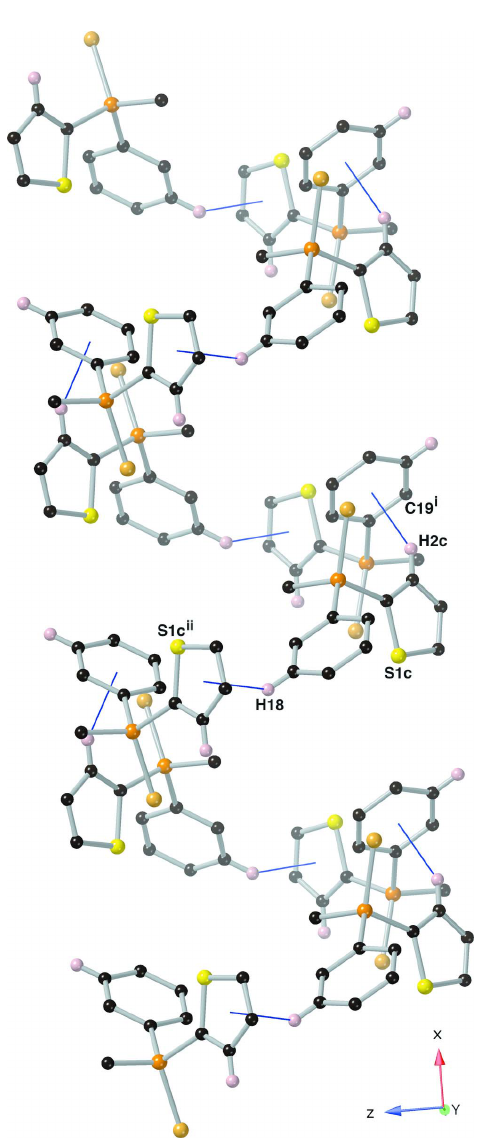
Figure 2 The C—H (cid:2)(cid:2)(cid:2) (cid:2) interactions (solid, blue lines) found in crystals of the title compound that form helices that run along the a -axis direction, depicted using a ball-and-stick model with standard CPK colors (Au = tan , hydrogen = light pink). The chlorine atoms, phenyl ring C1–C6, and any hydrogen atom not involved in a C—H (cid:2)(cid:2)(cid:2) (cid:2) interaction have been omitted for clarity. Only Part 1 is shown. Symmetry codes as in Table 1.